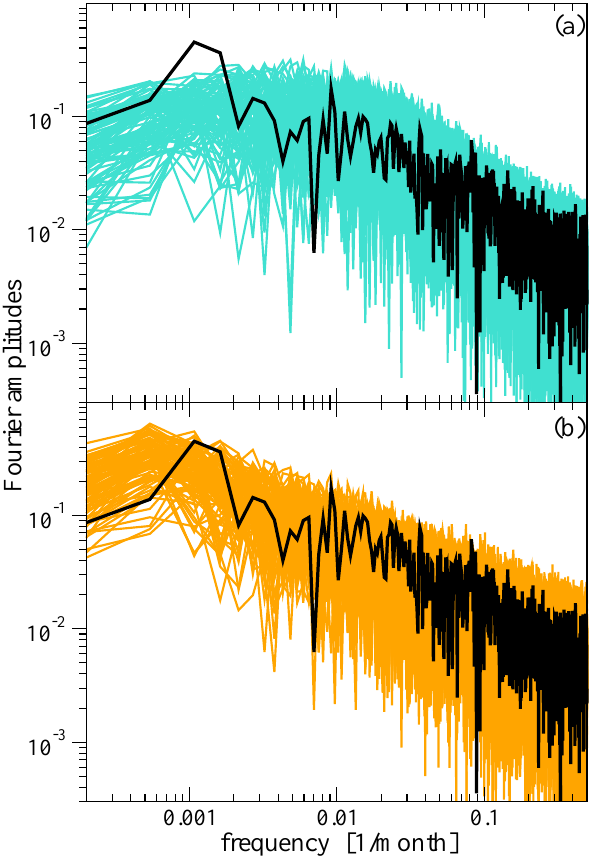
Fig. 5. Power spectra of (a) fitted AR(1) and (b) lrc model series ( β = 0 . 6) (thin coloured lines), together with the spectrum for the monthly mean SST anomaly record (thick black line). Note the double-logarithmic scales. (In each case, the standard Welch win- dowing was applied prior to the Fourier transform.